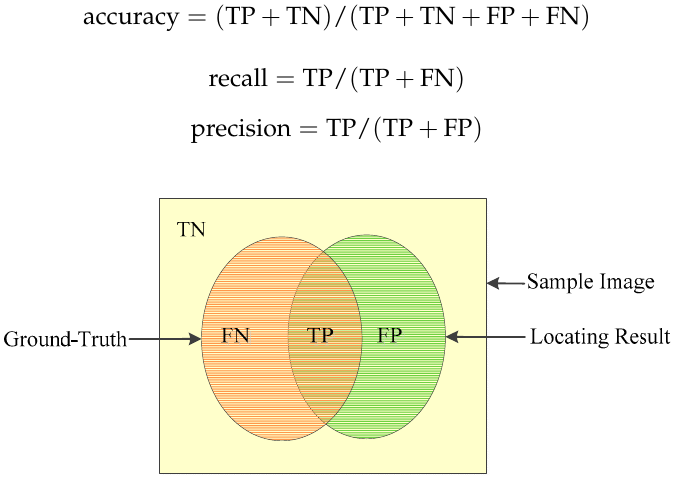
Figure 4. Definitions of TN, FN, TP, and FP.